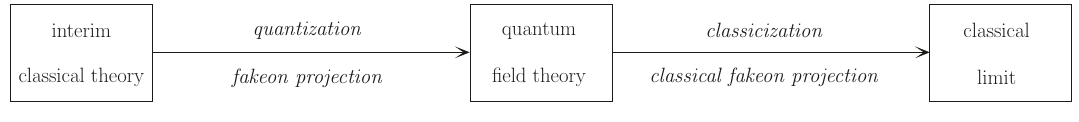
Figure 1 . Quantization/classicization